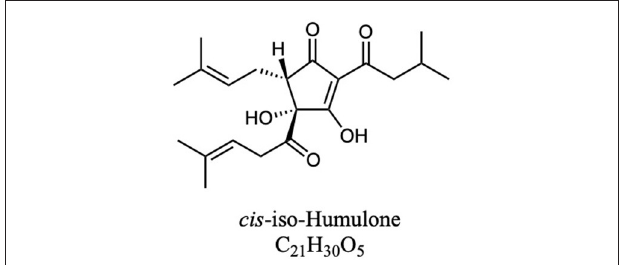
FIGURE 2 | One representative structure of the iso- α -acids that form when the α -acids isomerize during the brewing process (Each humulone molecule in Figure 1A can produce four iso-humulone isomers. Lupulones do not isomerize in this